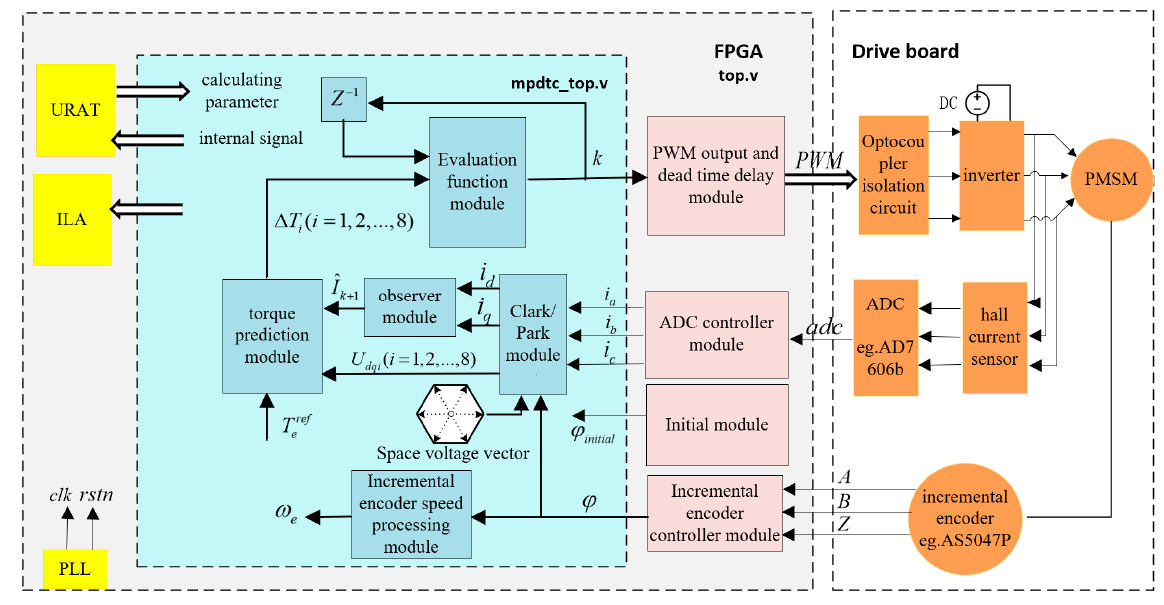
Figure 5. FPGA architecture design block diagram.